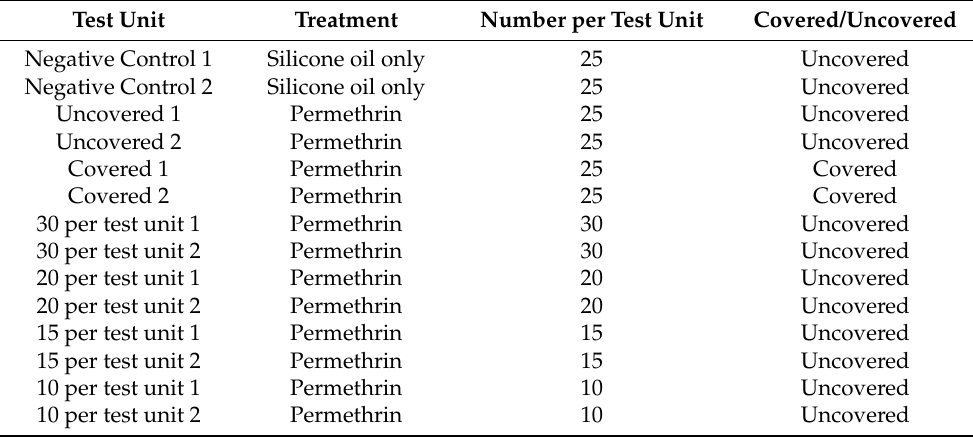
Table 1. Experimental outline of a single biological replicate to investigate the effect of covered vs. uncovered exposure tubes and number of mosquitoes per test unit. The test concentration was 0.043% for Anopheles gambiae (Kisumu, susceptible) testing and 0.75% for An. gambiae (Tiassal é 13, resistant) testing. Mosquito age was 2–5 days for both strains and all